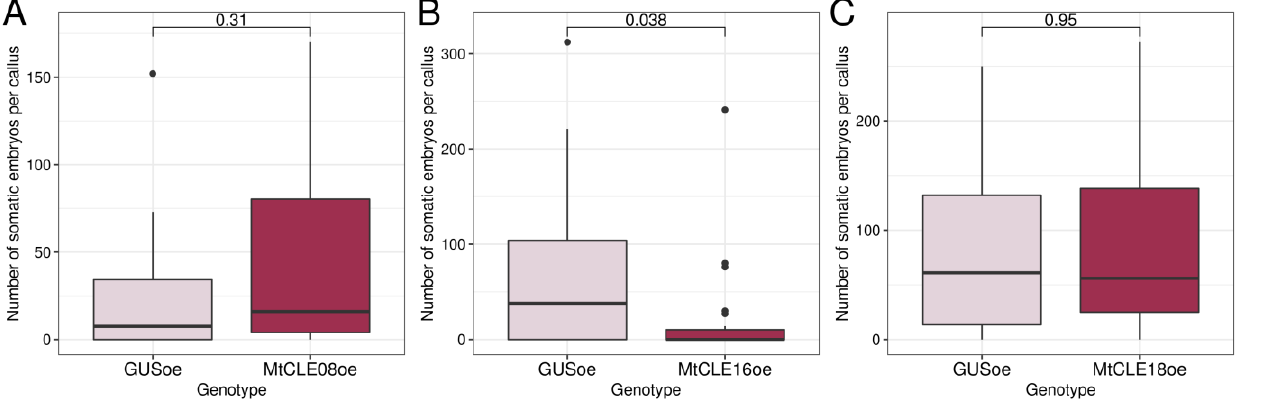
Figure 8. Number of somatic embryos per callus in transgenic calli with GUS and MtCLE08 ( A ), MtCLE16 ( B ) , or MtCLE18 ( C ) overexpression. Data are obtained from 10–24 calli for different samples. For MtCLE16 overexpressing calli, two experiments were performed with similar results. To assess the statistical significance of the observed differences, the Wilcoxon signed-rank test was used. Analysis of M. truncatula SE capacity and weight measurement of T0 calli were performed on